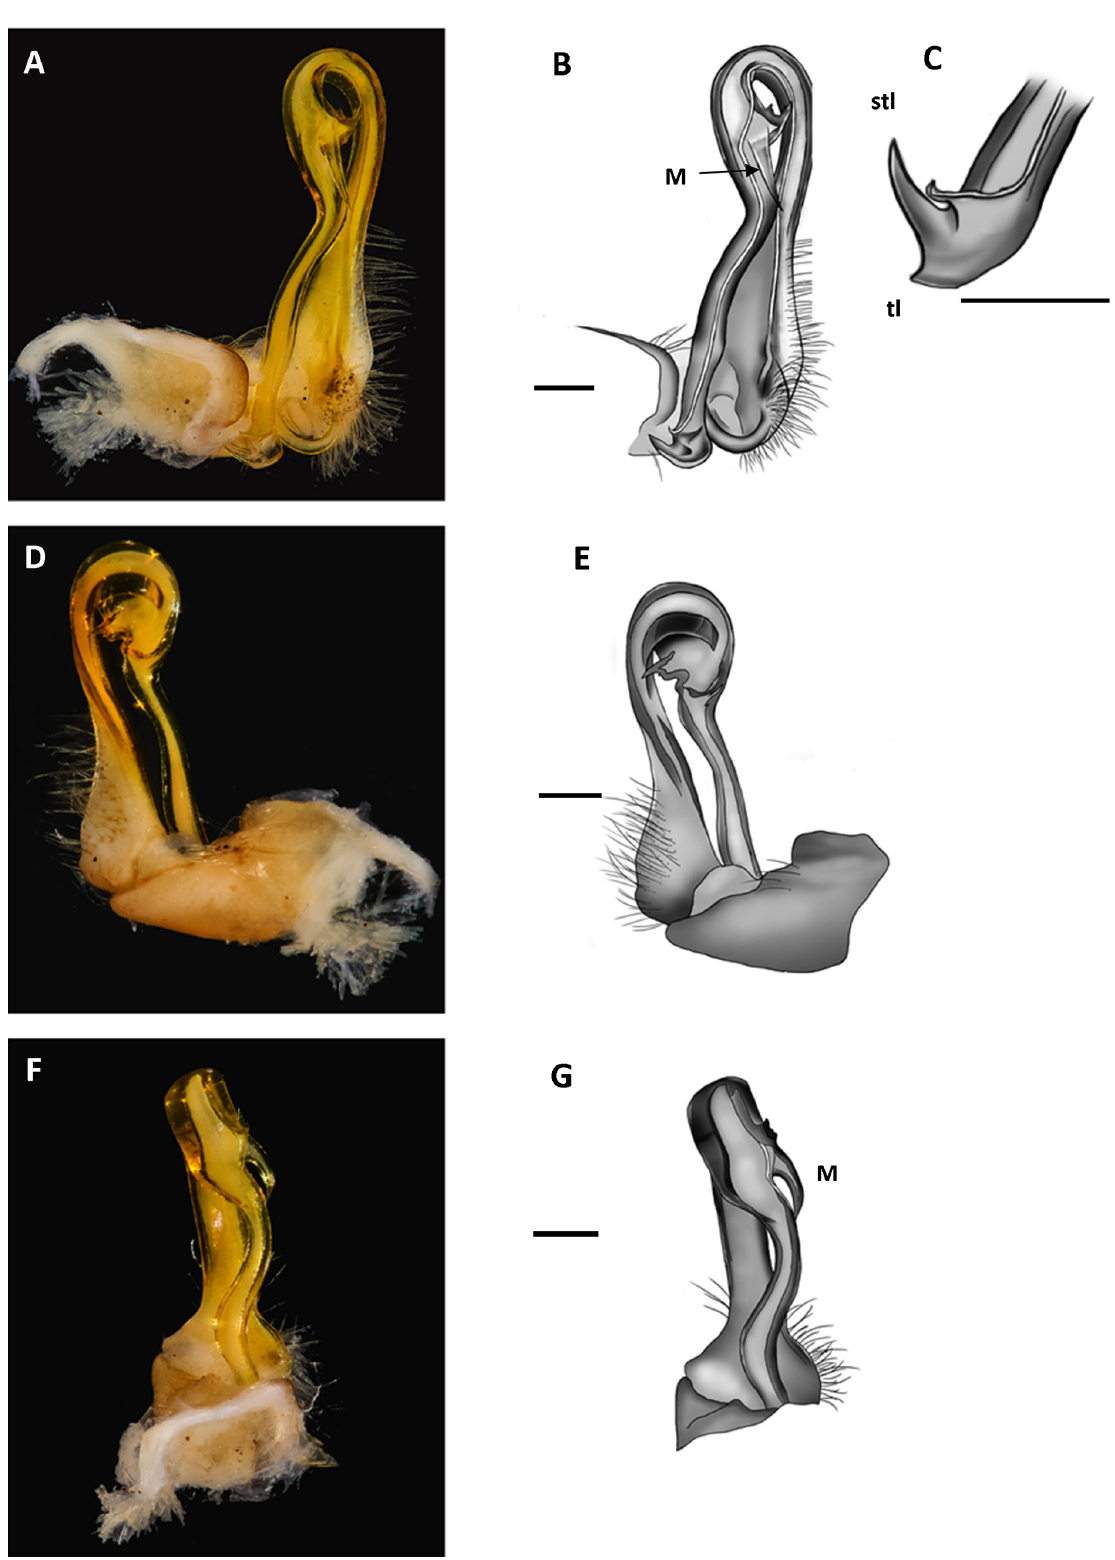
Fig. 13. Pogoropsis prolixopes Rosenmejer & Enghoff gen. et sp. nov., paratype, ♂, left gonopod (NHMD 621673). A–B . Mesal view. C . Apex of solenomere. D–E . Lateral view. F–G . Dorsal view. Abbreviations: M = Process M; stl = slender triangular lobe; tl = triangular lobe. Scale bars: 0.5